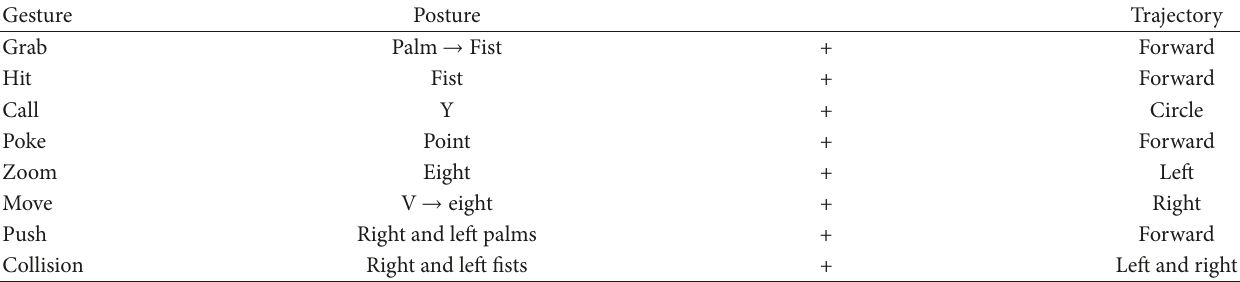
Table 10: The names of gesture classes and their compositions.